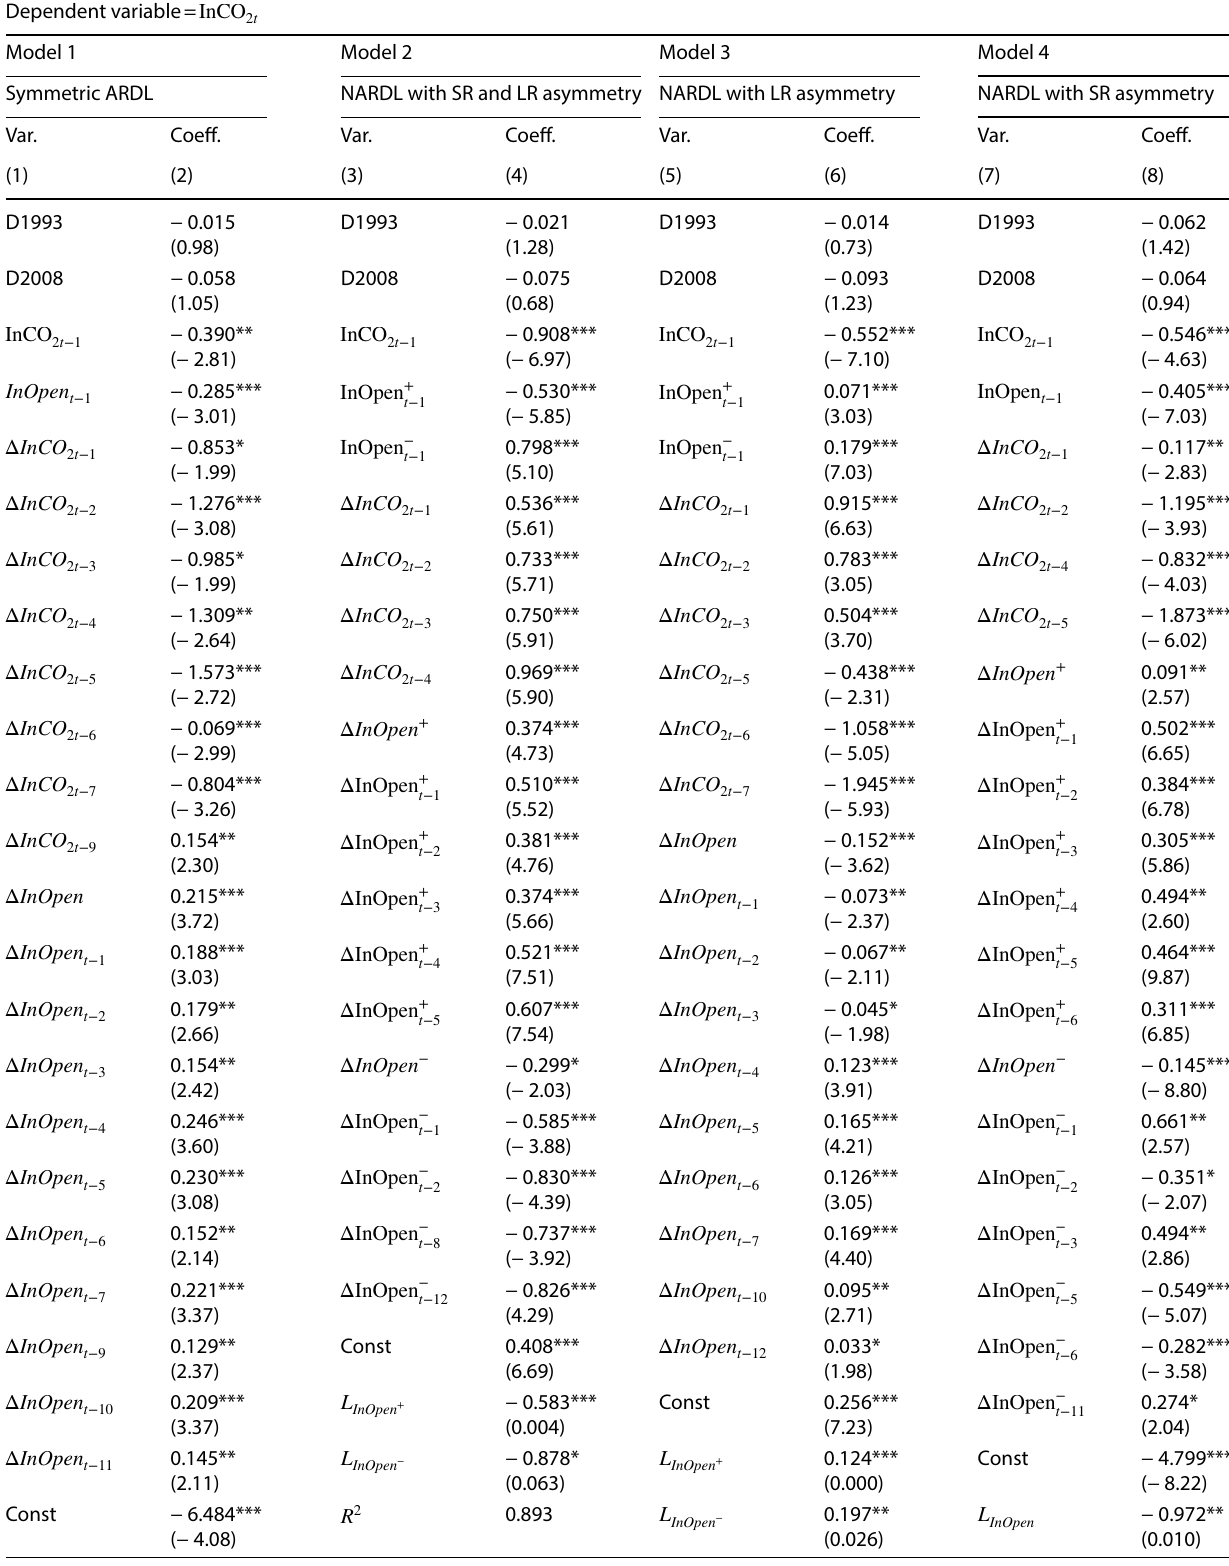
Table 19 Full-information estimates of both symmetric ARDL and nonlinear ARDL (NARDL) models in SADC region while controlling for structural break